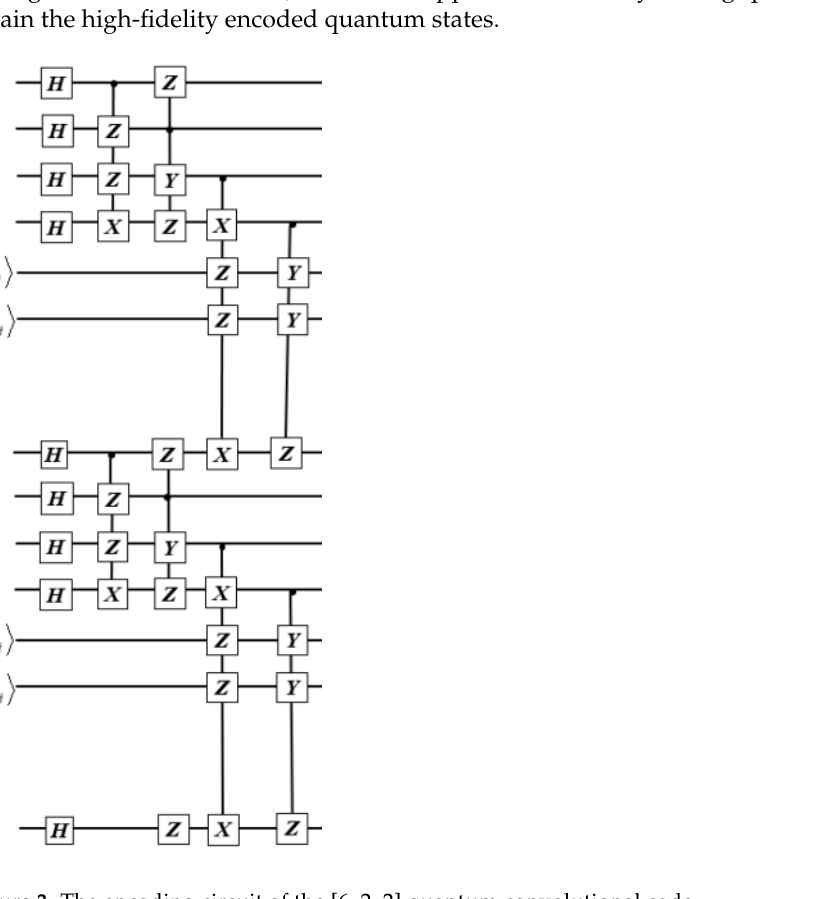
Figure 3. The encoding circuit of the [6, 2, 2] quantum convolutional